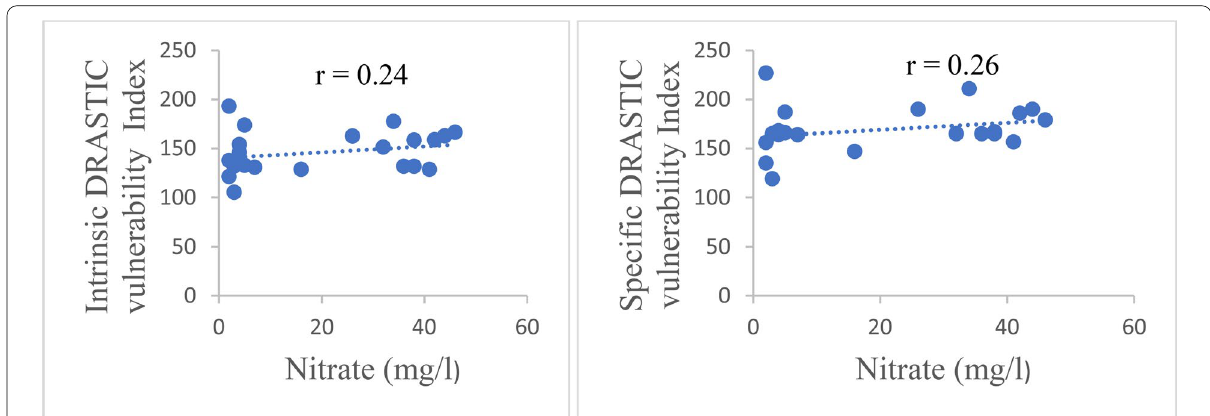
Fig. 7 Correlation between Intrinsic DRASTIC vulnerability index and NO3 (left) and Correlation between Specific DRASTIC vulnerability index and NO3 (right)